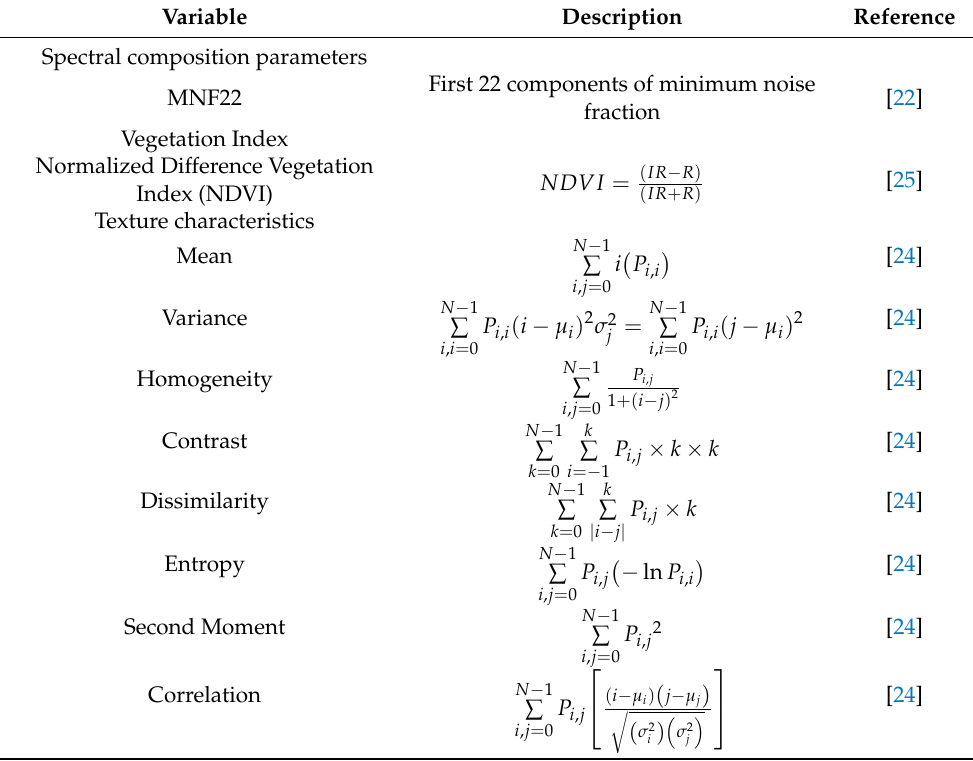
Table 3. Variable and their respective descriptions and